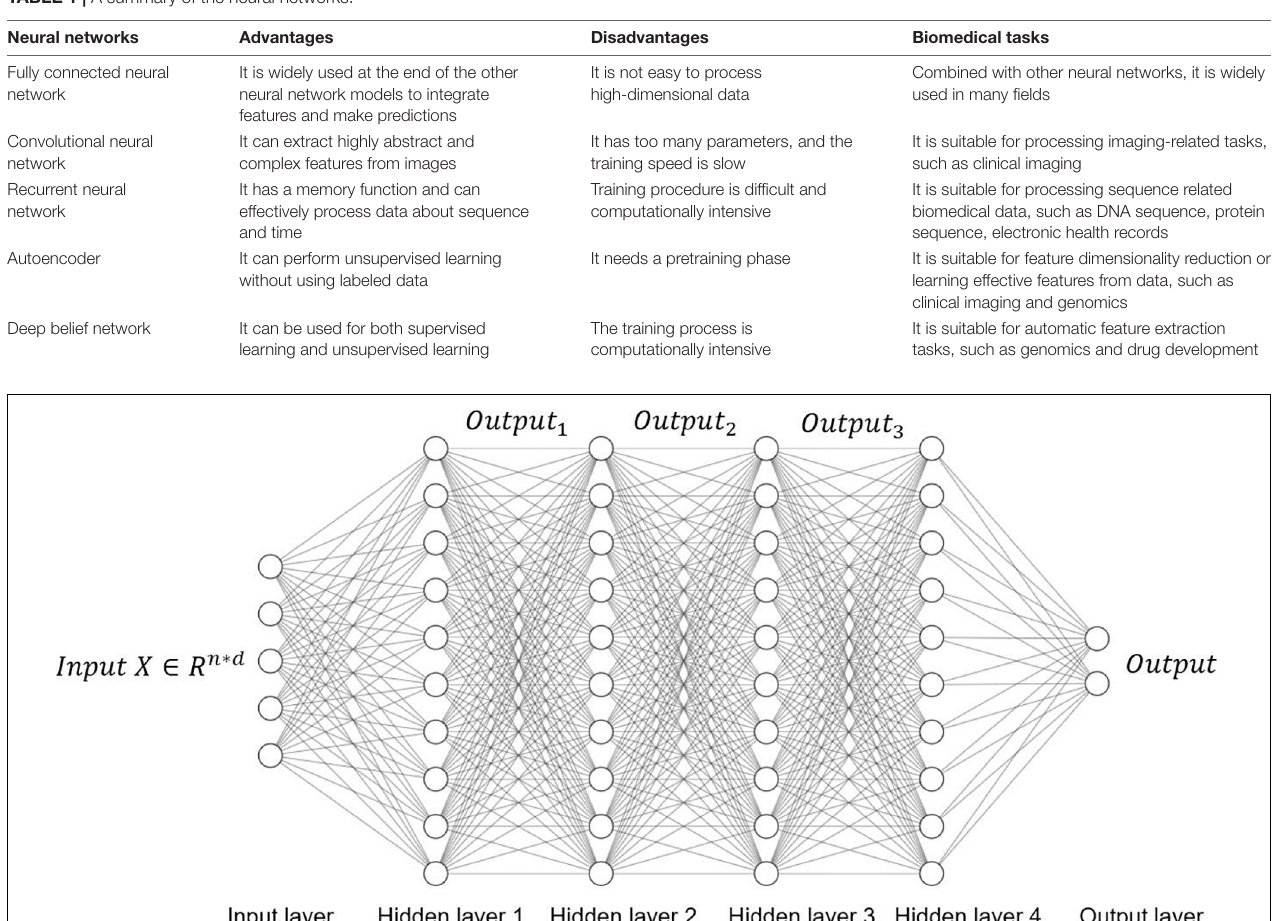
TABLE 1 | A summary of the neural networks.